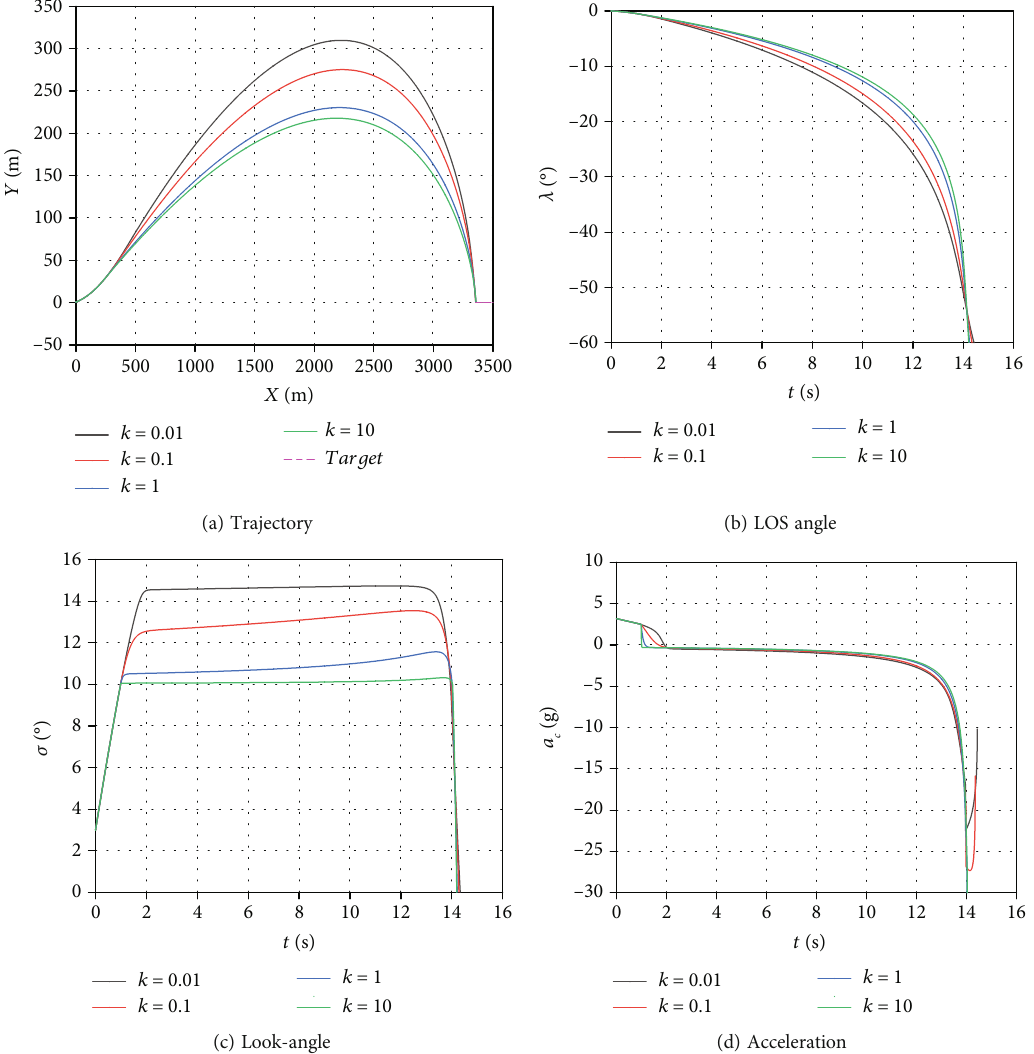
Figure 9: The results considering di ff erent switching